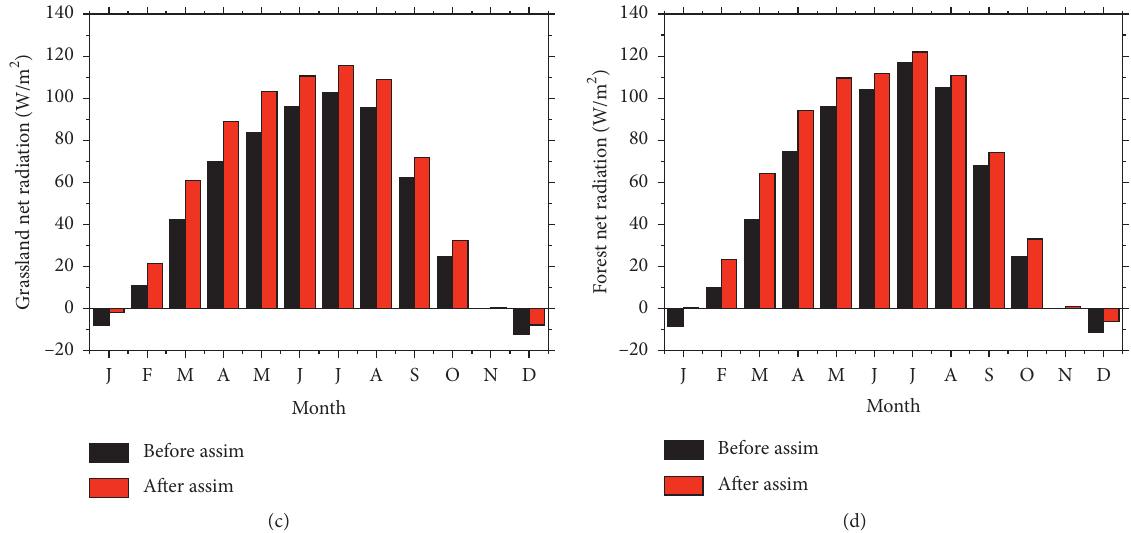
Figure 9: Spatial average of the monthly average net radiation simulations before and after assimilation for the four main LUCs: (a) urban; (b) cropland; (c) grassland; (d)